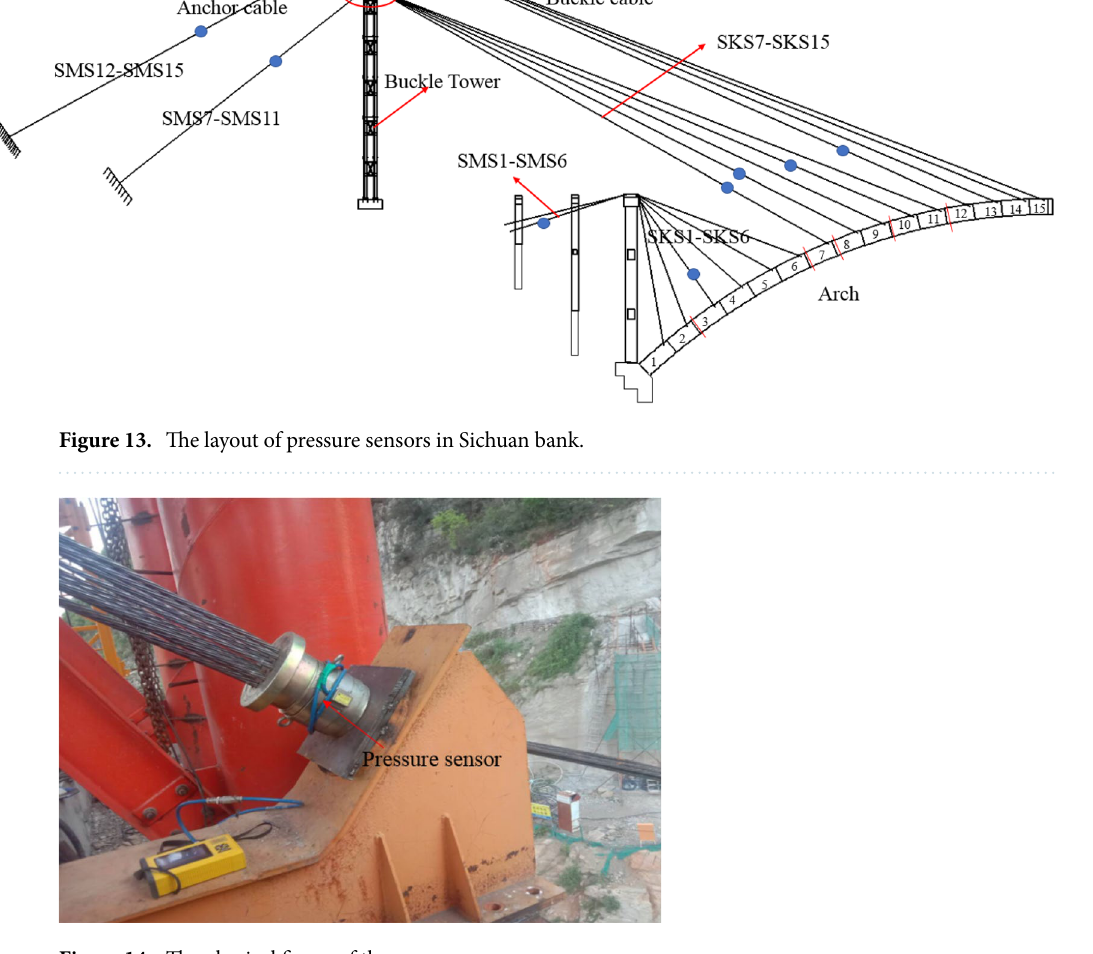
Figure 14. The physical figure of the pressure sensor.